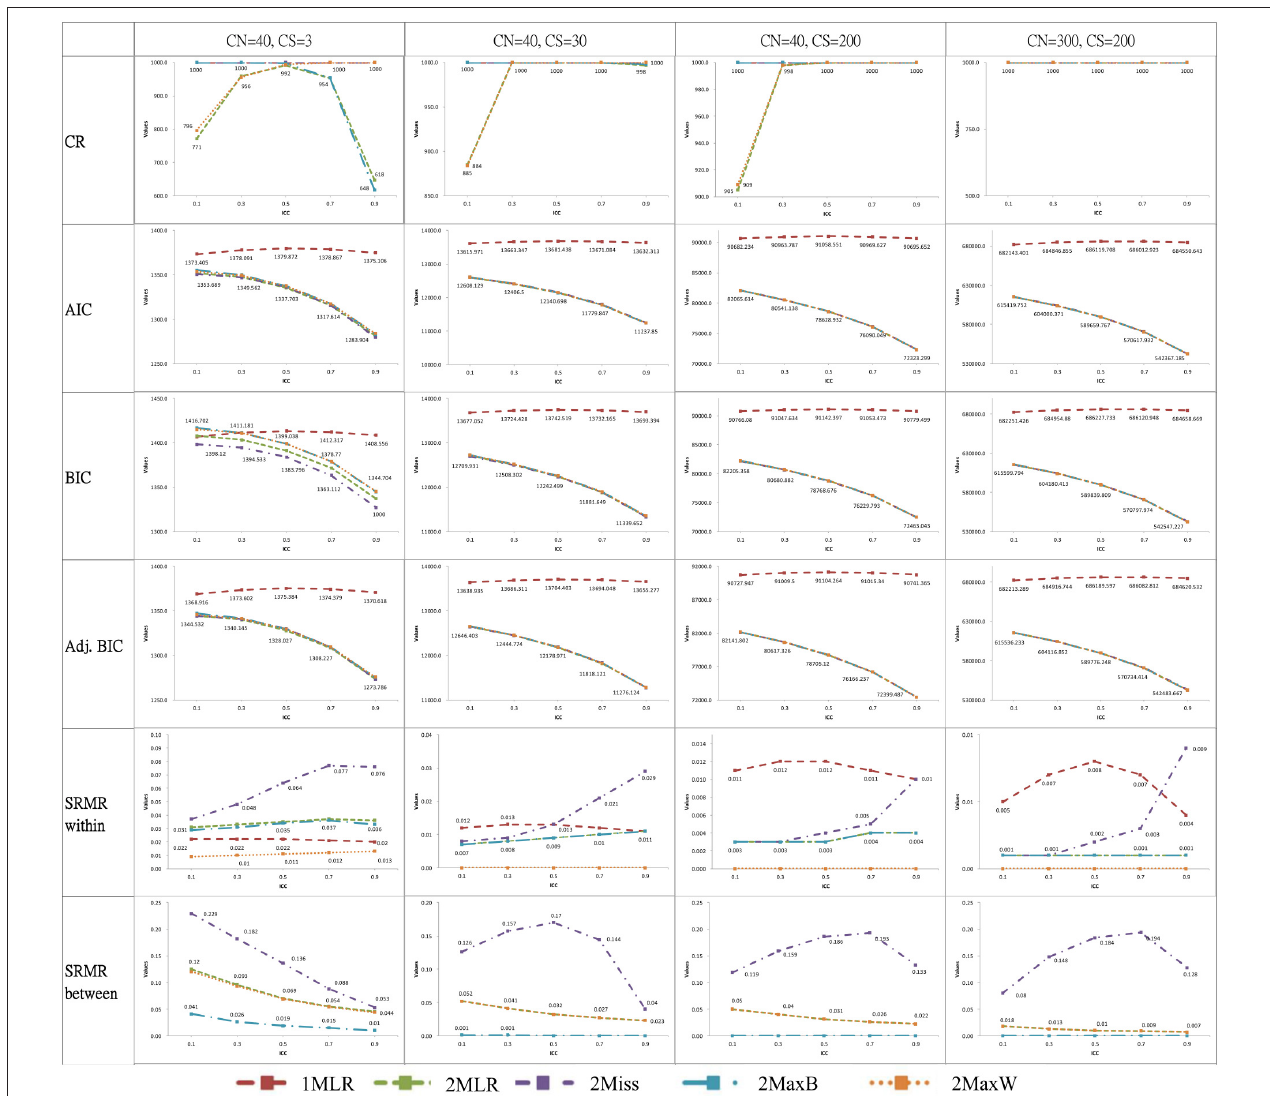
FIGURE 3 | Plots of selected analytical outputs of ICC against fit statistics across different modeling strategies. CN, Cluster number; CS, Cluster size; CR, Convergence rate of simulations; ICC, Intraclass correlation. 1MLR, the one-level design-based model; 2MLR, the two-level model-based model and the true model; 2MaxB, the two-level maximum model with saturated model in between level and true model in within level; 2MaxW, the two-level maximum model with true model in between level and saturated model in within level; 2Miss, the miss-specified two-level model by constraining the factor loading estimates of the between and within levels to be the